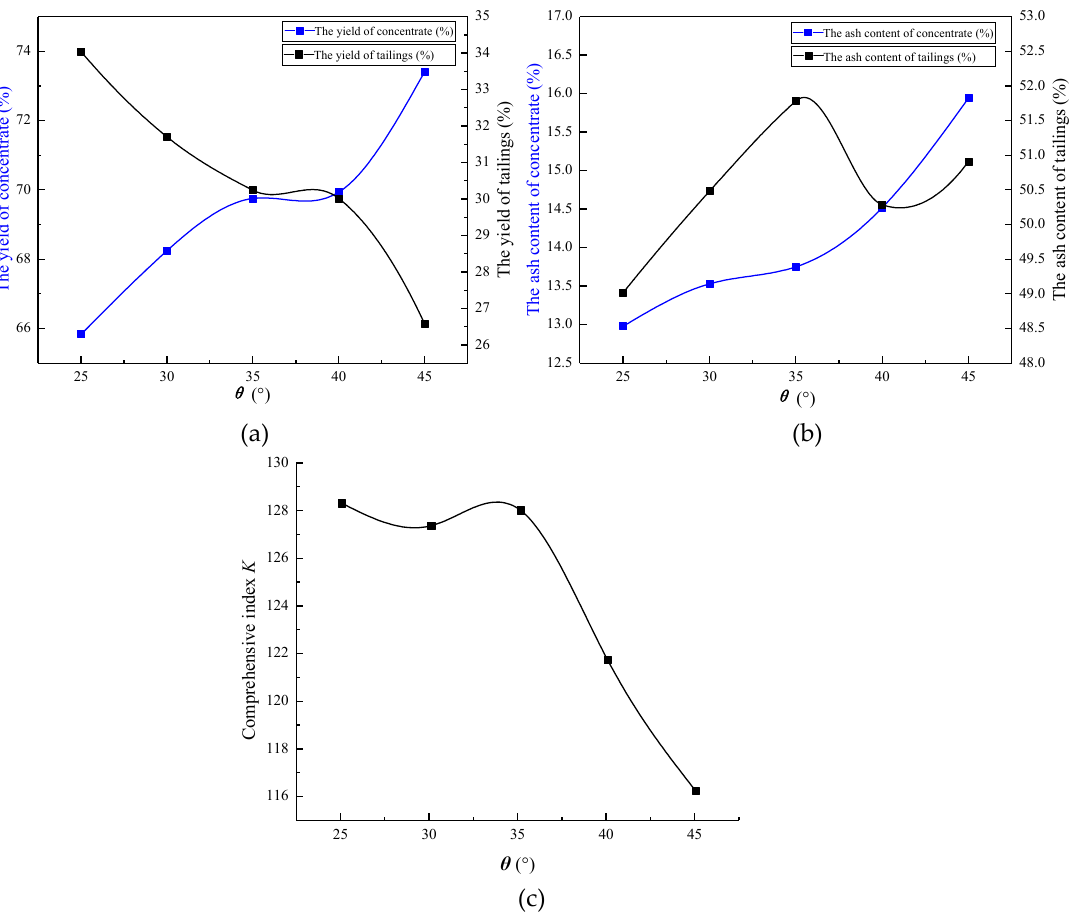
Figure 8. E ff ect of θ on the separation e ff ect. ( a ) E ff ect of the θ on yield; ( b ) e ff ect of the θ on the ash Figure 8. Effect of θ on the separation effect. ( a ) Effect of the θ on yield; ( b ) effect of the θ on the ash content; ( c ) e ff ect of the θ on K content; ( c ) effect of the θ on K .